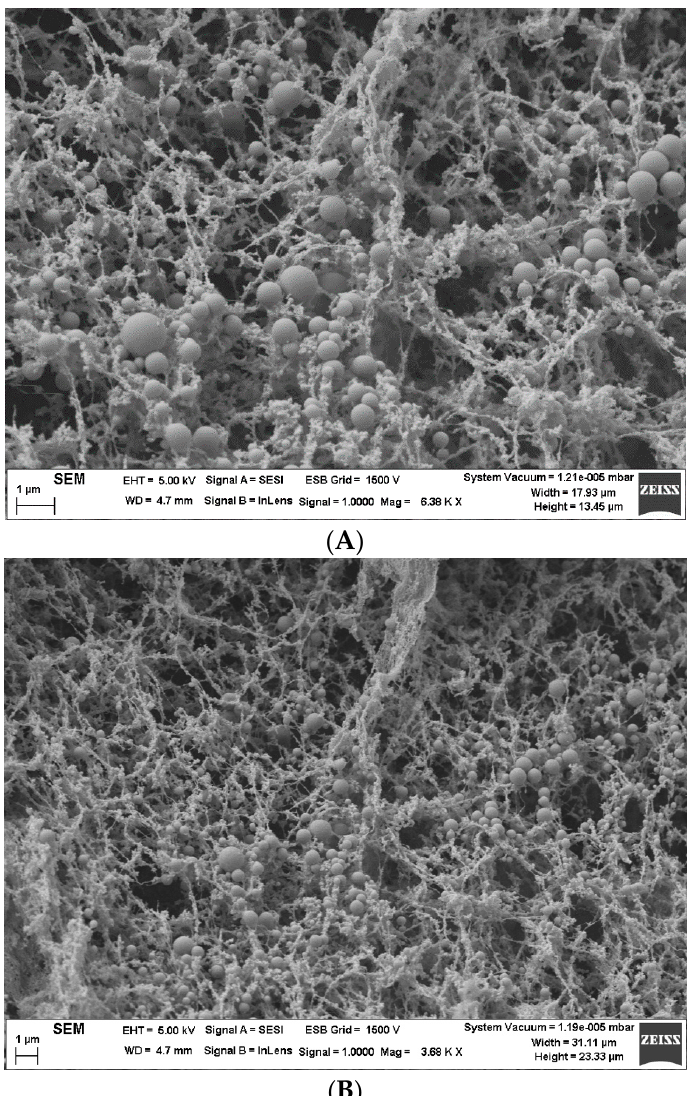
Figure 5. ( A ) Microstructure observed by FESEM for the 75/25 system, ( B ) Microstructure observed by FESEM for the 50/50